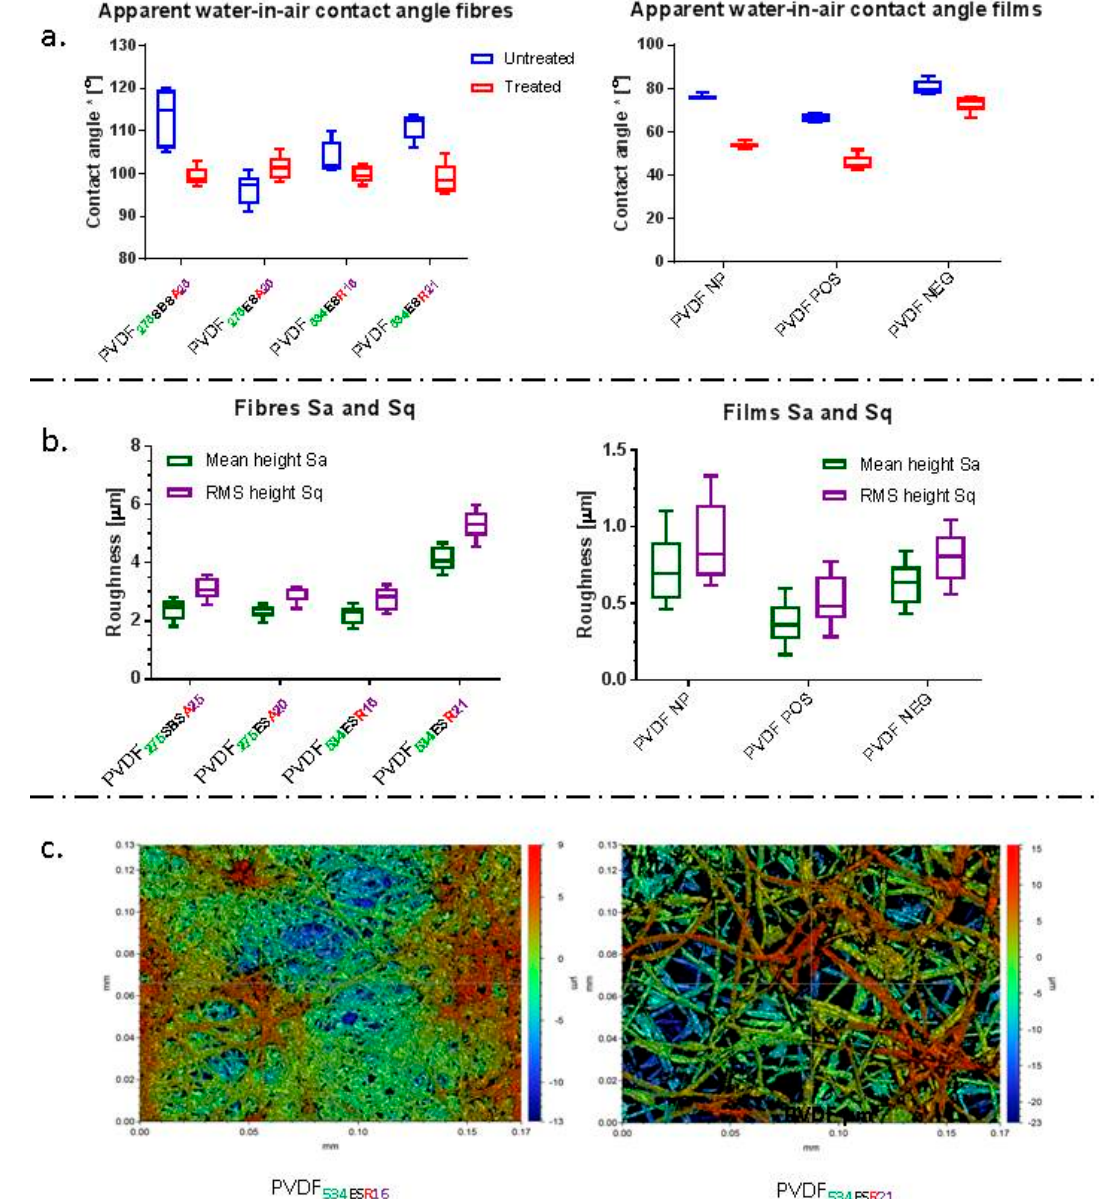
Figure 3. ( a ) Apparent water-in-air contact angle values obtained for untreated and treated (pre-conditioned with cell culture media and dried) fibre mats and films, * represents apparent water-in-air contact angle ( b ) Distribution of roughness parameters obtained for fibrous PVDF membranes and PVDF films. ( c ) Representative optical profilometry images obtained for different samples.